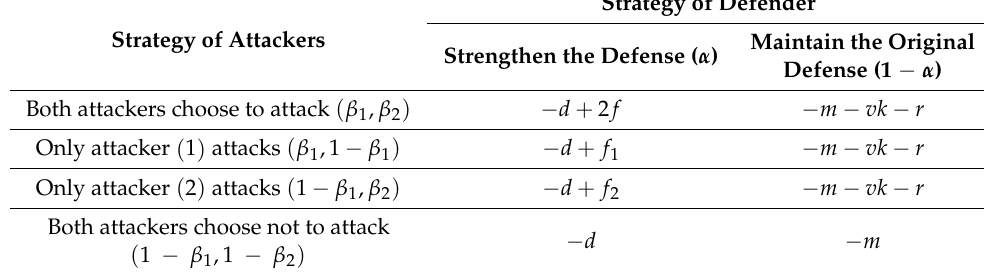
Table 3. Payoff matrix of the